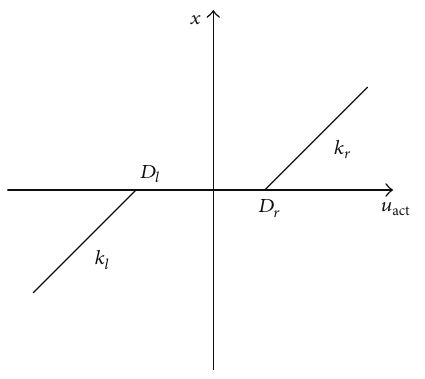
Figure 4: Characteristic of nonsymmetric dead-zone.